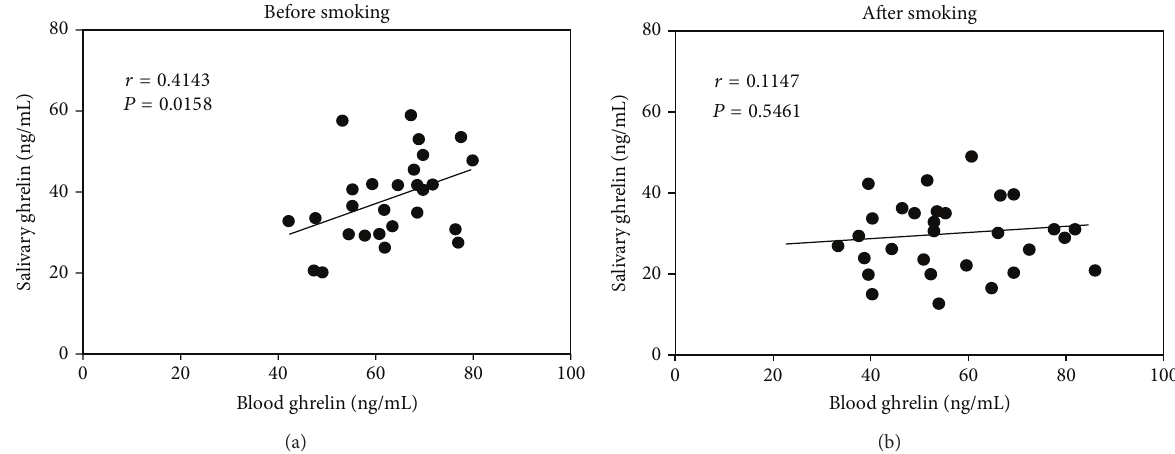
Figure 2: Relationship between blood and salivary ghrelin levels. Dot plots showing a positive correlation between blood and salivary ghrelin before smoking (a). However, after acute one-cigarette smoking no correlation was observed